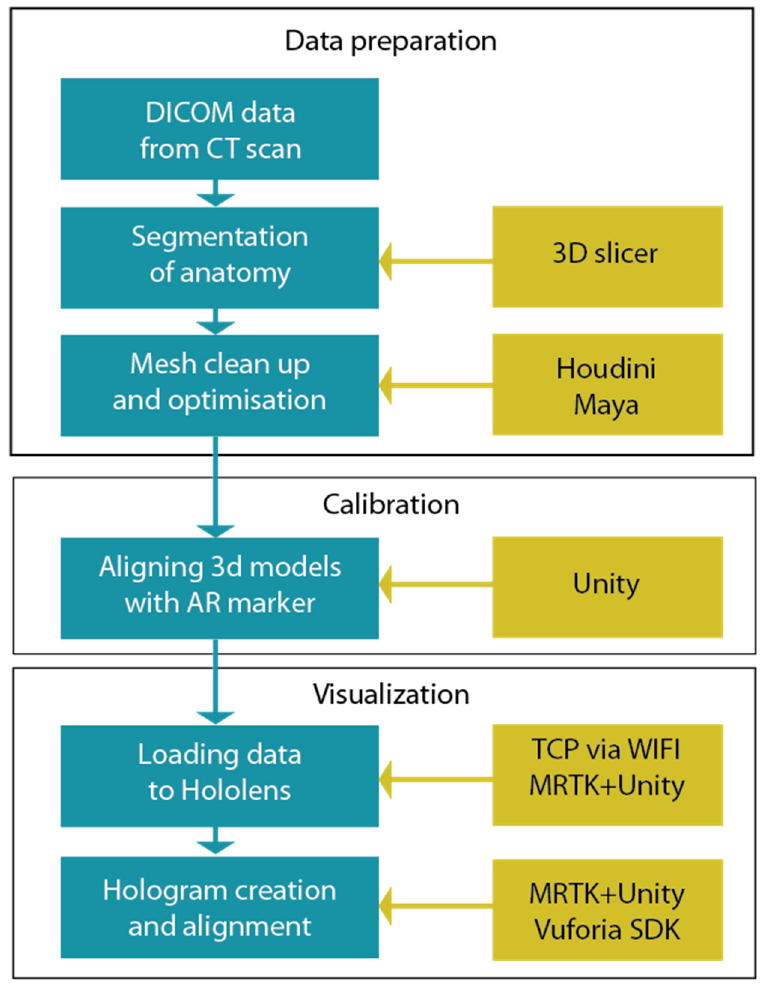
Figure 1. Three main stages of the developed